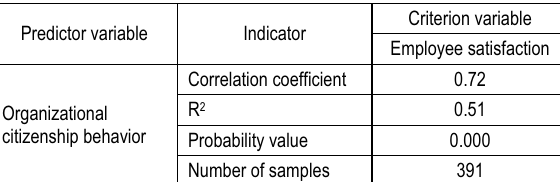
Table 7. The relationship between organizational